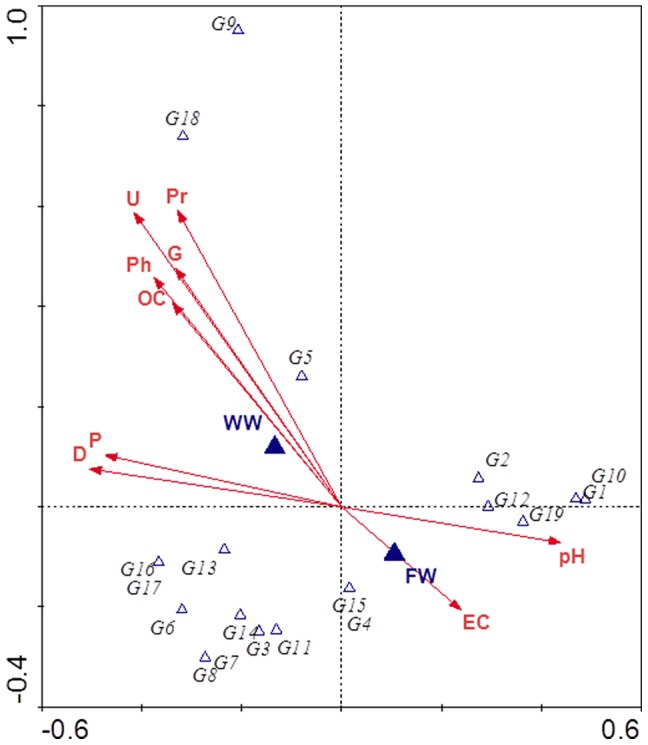
Canonical correspondence analysis (CCA) of the AMF communities found and soil properties at the soil irrigated with fresh water (FW) and treated wastewater (WW).The eigenvalues of the first and second axes in the two-dimensional ordination diagrams are as follows: CCA1∶0.82 and CCA2∶0.65. Ph: Alkaline Phosphatase, U: Urease, D: Dehydrogenase, Pr: Protease, G: β-glucosidase, OC: Total organic carbon, EC: Electrical conductivity, P: exchangeable P.